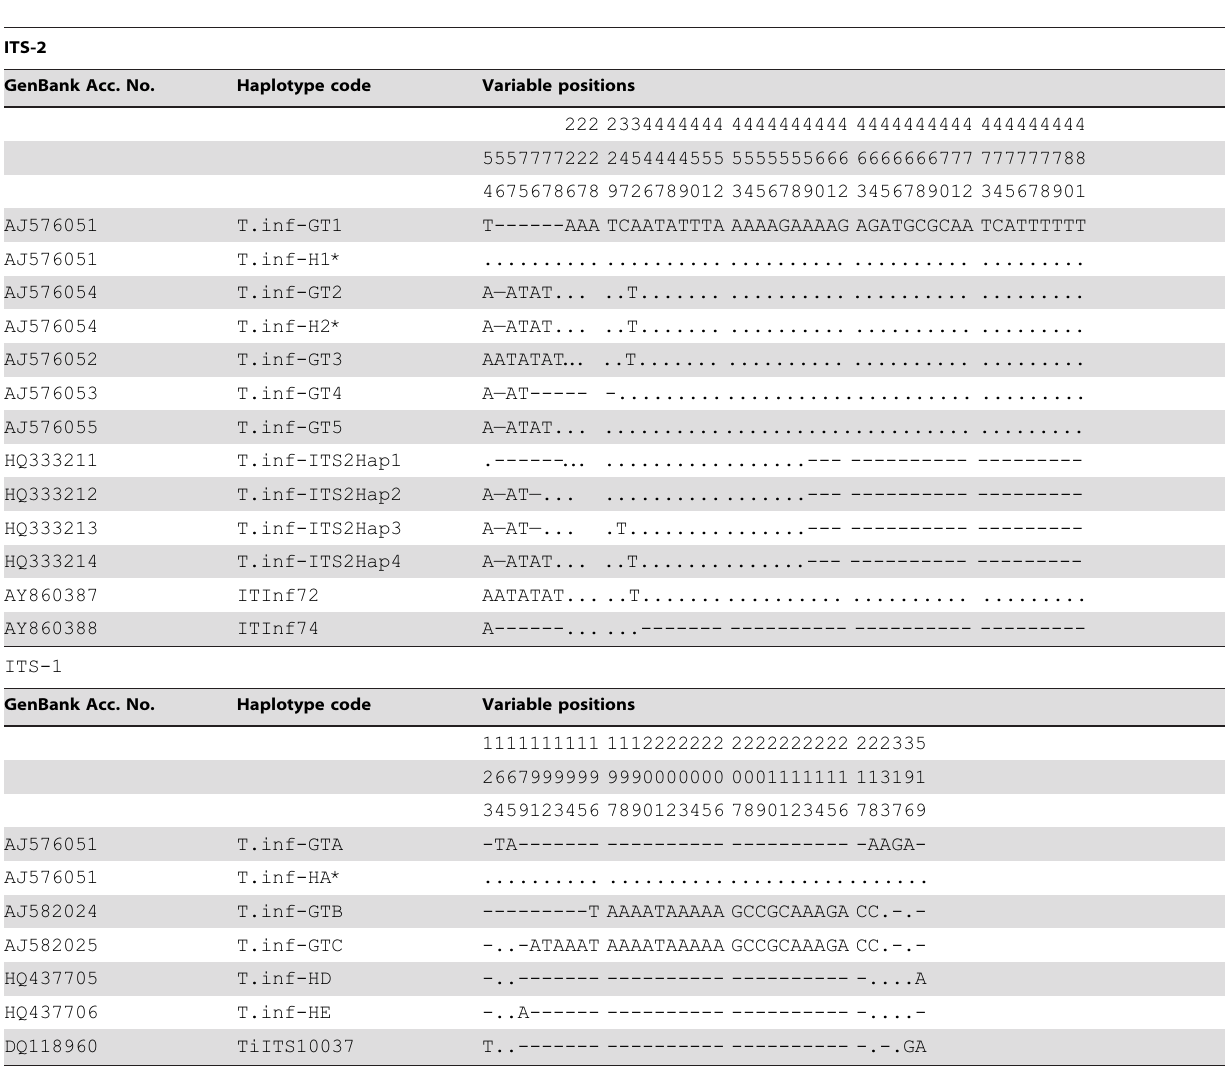
*haplotypes from present paper; variable positions=numbers (to be read in vertical) refer to variable positions obtained in the ITS-2 and ITS-1 alignments obtained with MEGA 6.0; symbols: identical positions=.; indel=-; indel position in 3 9 end of the alignment=not sequenced. Haplotypes that seem to be identical: T.inf-GT1=T.inf- ITS2Hap1; T.inf-GT2=T.inf-ITS2Hap4; T.inf-GT3=ITInf72.